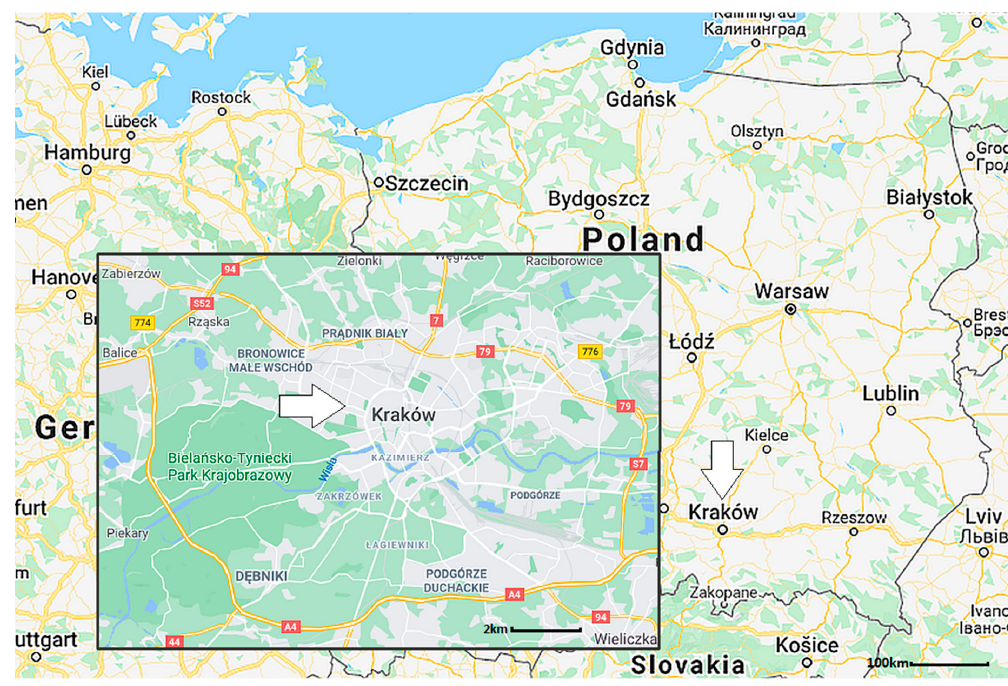
Figure 1. Sampling Figure 1. Sampling site.